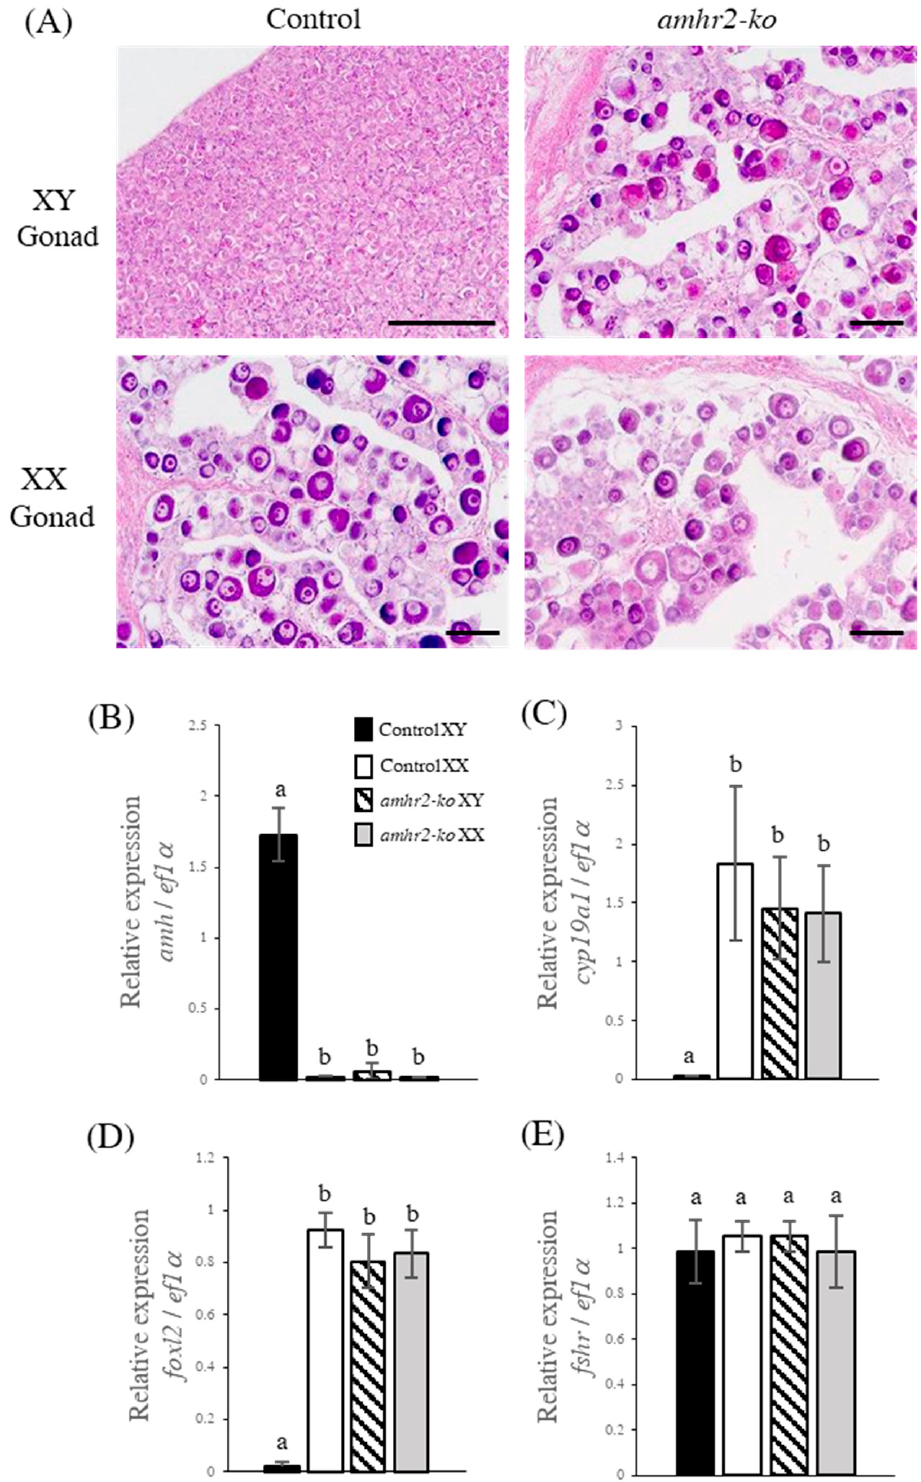
Figure 3. Phenotypic analysis of amhr2 knockout mutants. Histological images of gonads from controls and amhr2 mutants at 200 dah ( A ). Scale bar, 100 µ m. Real-time PCR analyses of amh ( B ), cyp19a1 ( C ), foxl2 ( D ), and fshr ( E ) expressions were carried out using the gonads of the flounder at 200 dah. Different letters denote significant differences at p < 0.01.